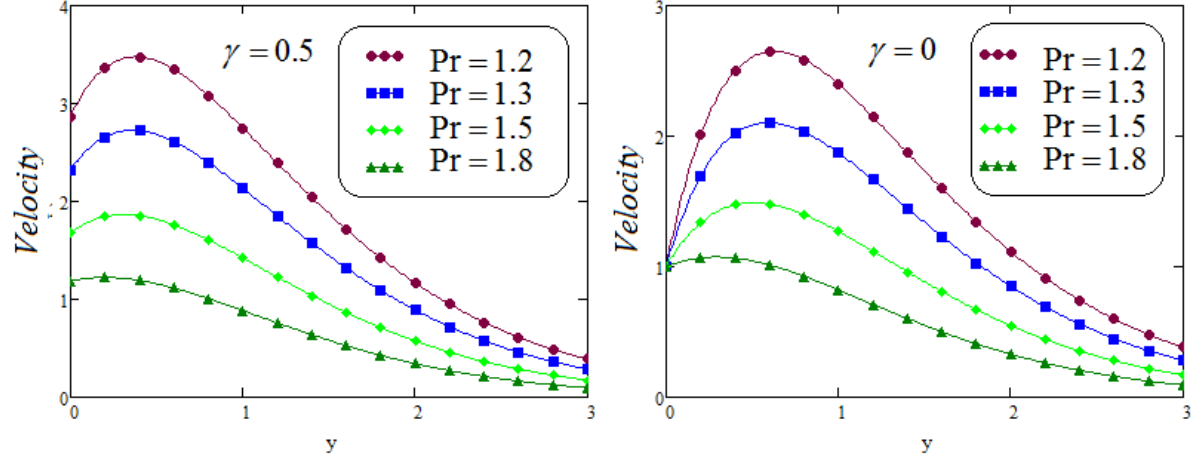
Figure 11. Velocity profile for varied values of P r with and without slip effect γ when f ( t ) = sint , t = 1.5, α = 0.5, β = 0.3, Gr = 3.5, λ 1 = 0.6, λ 2 = 0.2, M = 2.